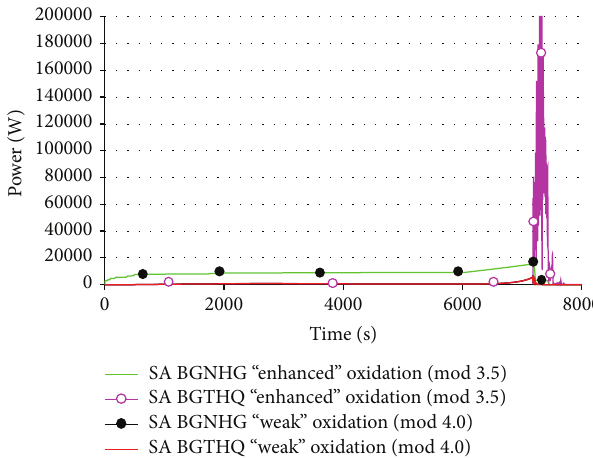
Figure 15: QUENCH-06 test calculation using RELAP/SCDAPSIM mod 4.0 and mod 3.5 with default SCDAPSIM model for the zirconium oxidation. BGNHG: total core heat generation. BGTHQ: core total oxidation heat